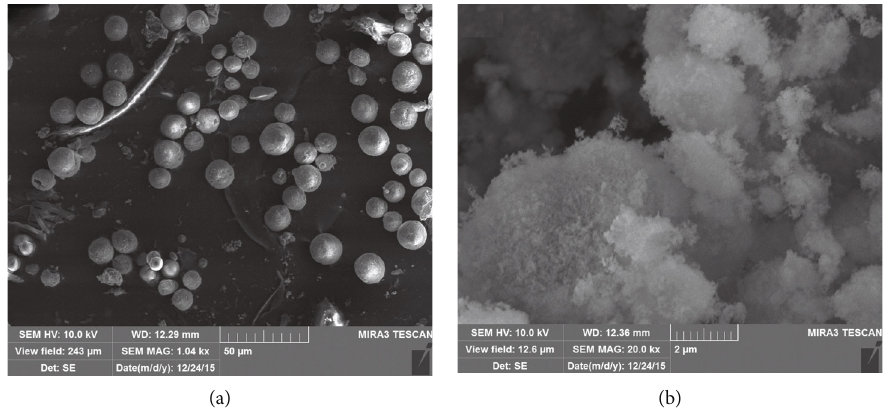
Figure 1: SEM images of (a) micro-HAP (12 μ m) and (b) nano-HAP (20